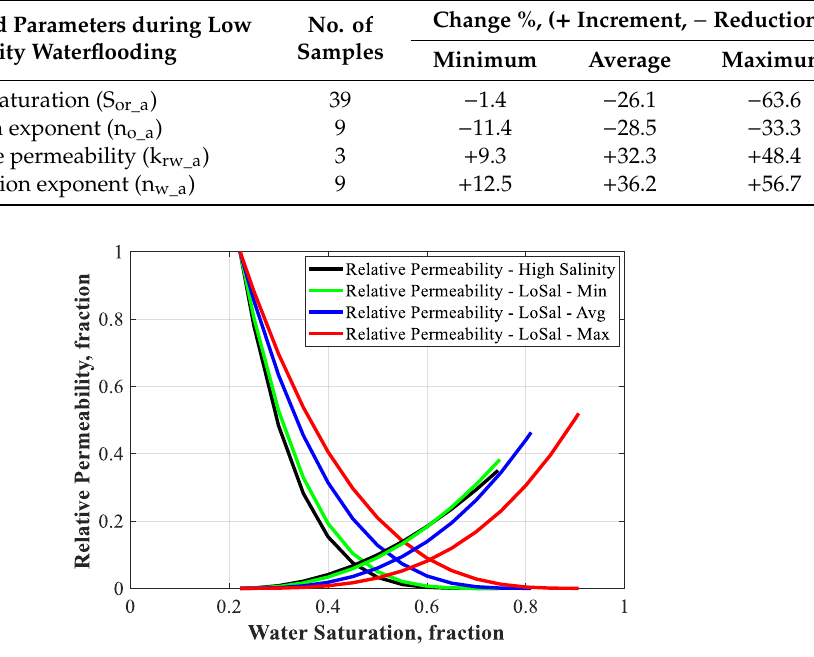
Figure 1. The generated relative permeability sets for a fractured formation using the calculated ranges in Table 2 for the saturation exponents and saturation endpoints. The black curves represent the original relative permeability set, while the coloured curves represent the relative permeability of the flooded region by low salinity brine for three levels of alterations.